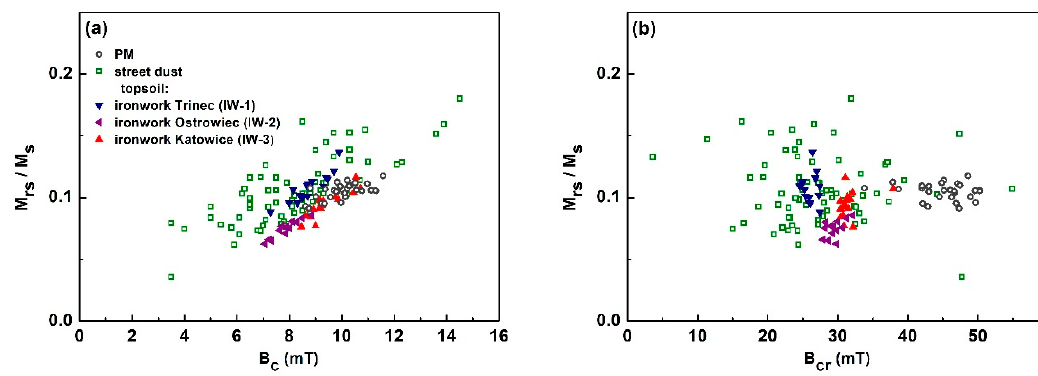
Figure 9. Distribution of M rs /M s ratio versus the parameters coercivity (B c ) ( a ) and remanence coercivity (B cr ) ( b ).